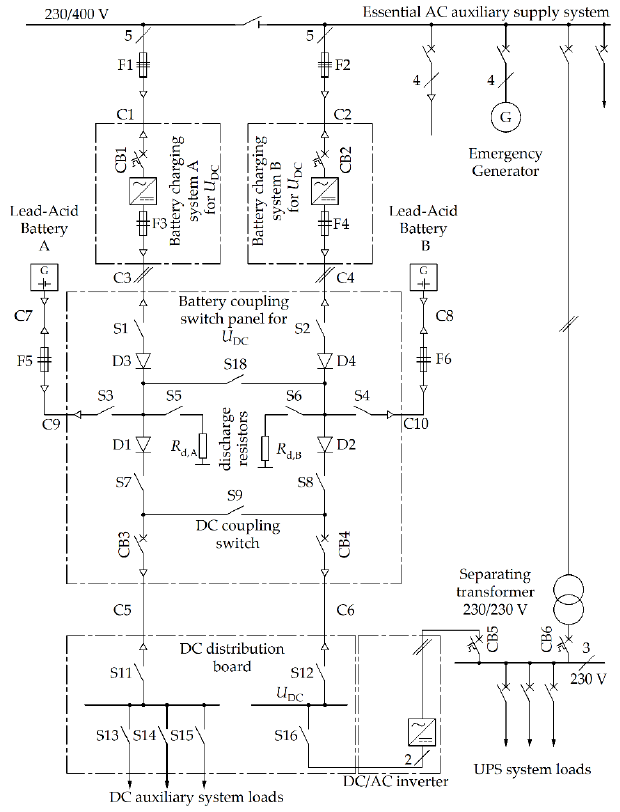
Figure 1. Presentation of a DC auxiliary system in a substation with lead-acid battery (LAB), switching devices and DC auxiliary system loads.